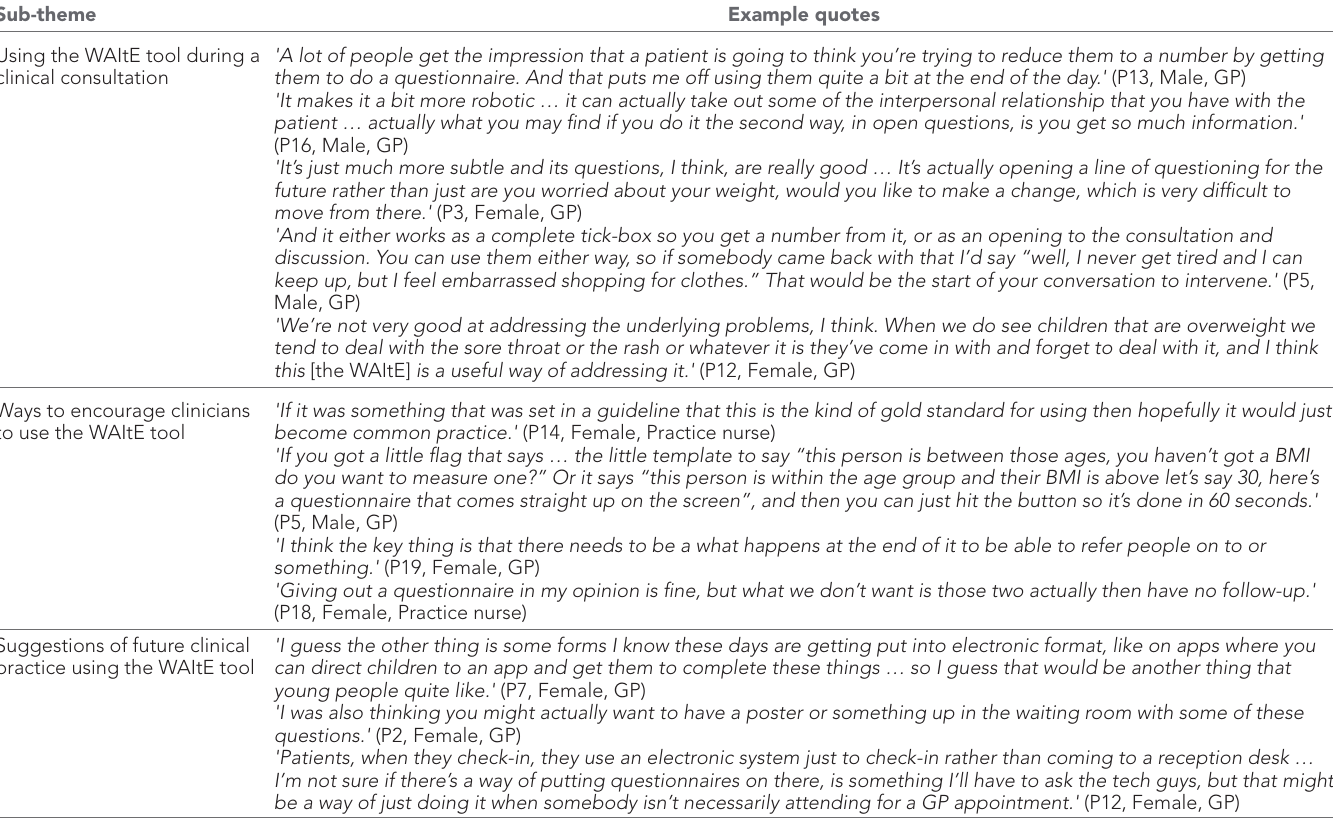
Table 4 Supporting quotes for the 'Perceived challenges, benefits, and methods of implementing the WAItE tool' theme Sub-